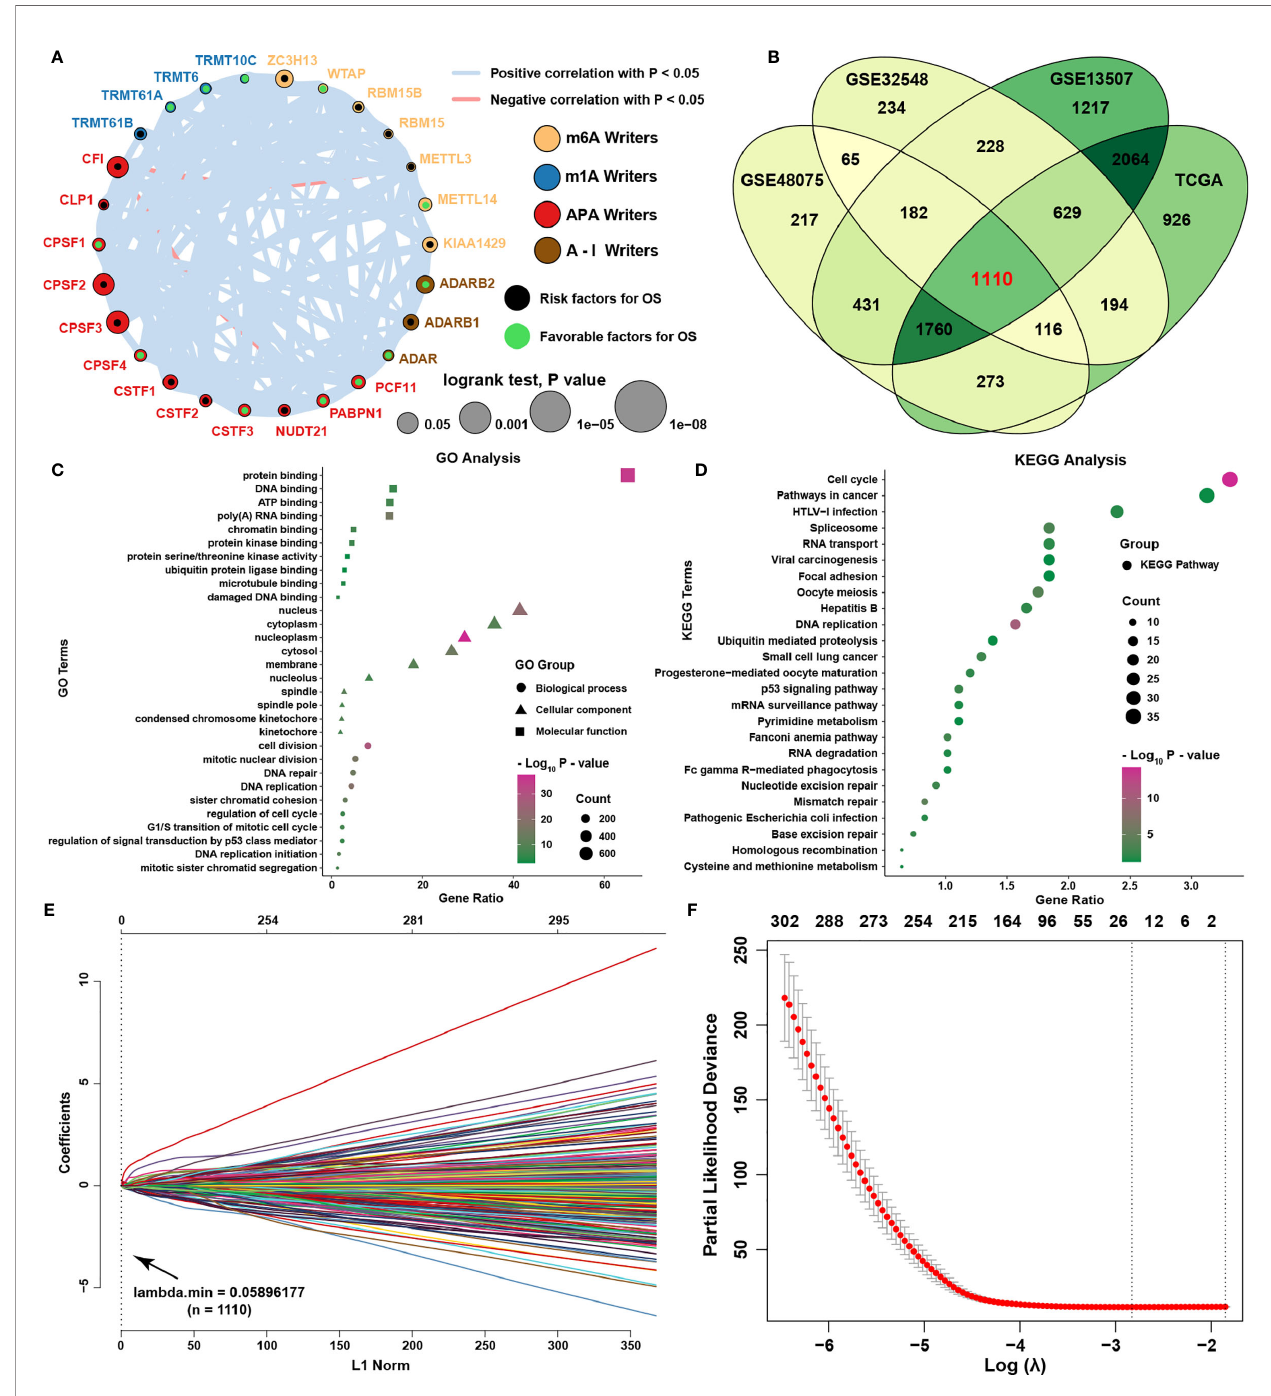
FIGURE 2 | Identifying representative candidate prognostic writer-related genes. (A) The interactions among writer genes in BLCA. The lines linking regulators show their interactions, and line thickness shows the correlation strength between regulators. A negative correlation is marked with red, and a positive correlation is marked with gray. (B) Venn diagram for writer-related genes in four independent datasets. (C, D) GO and KEGG analyses of writer-related genes and terms are shown on the left. (E, F) Ten ‐ fold cross ‐ validation for tuning parameter selection in the LASSO model and the LASSO coef fi cient pro fi les of candidate genes are